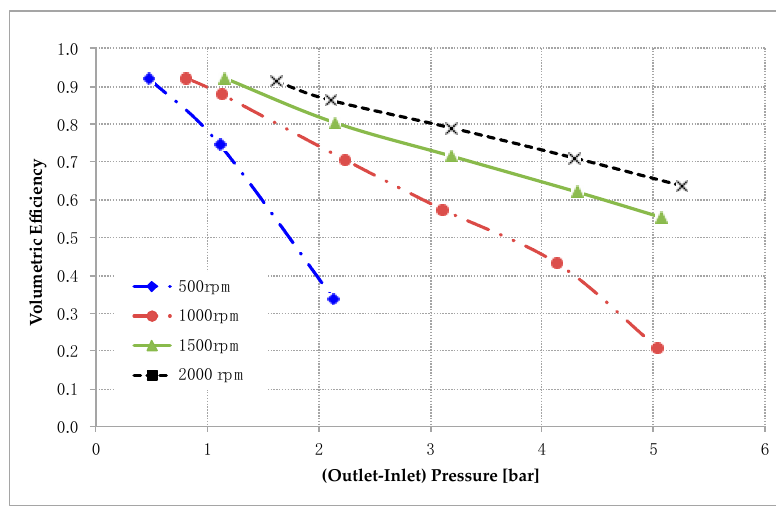
Figure 14. mTGp volumetric efficiency sintered metal inner gear performance with ‘in-out sleeve passageway’ configuration.